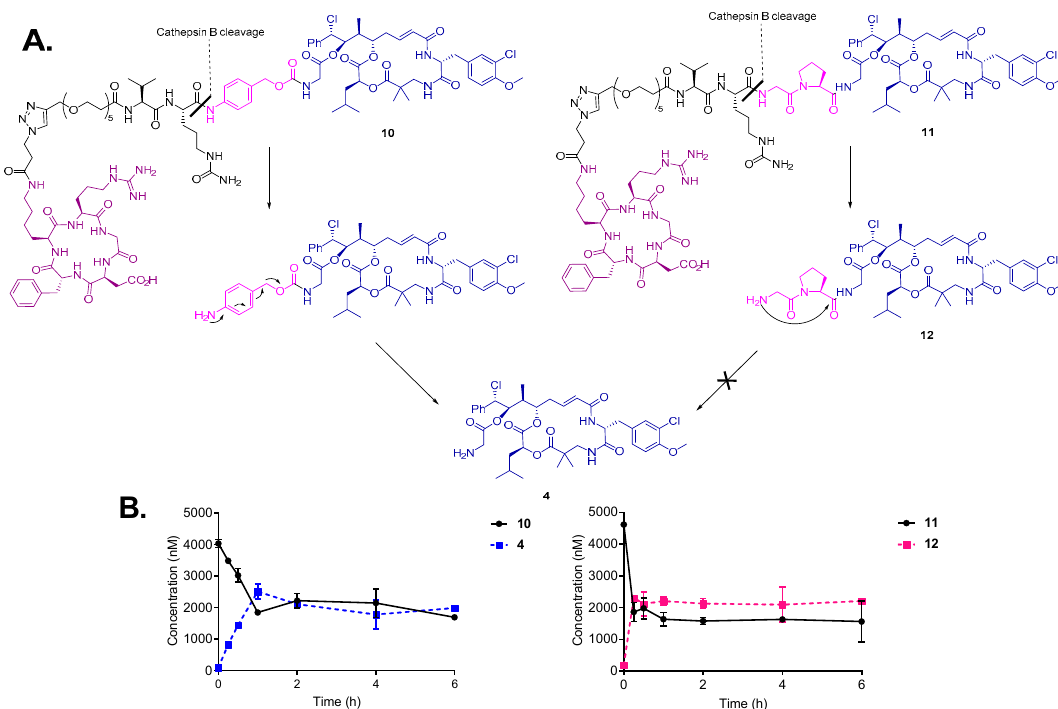
Figure 3. ( A ) Cleavage and self-immolation mechanism of conjugates 10 and 11 in the presence of cathepsin B enzyme. ( B ) Cleavage and metabolism of conjugate 10 (left) and 11 (right) upon incubation with cathepsin B enzyme.